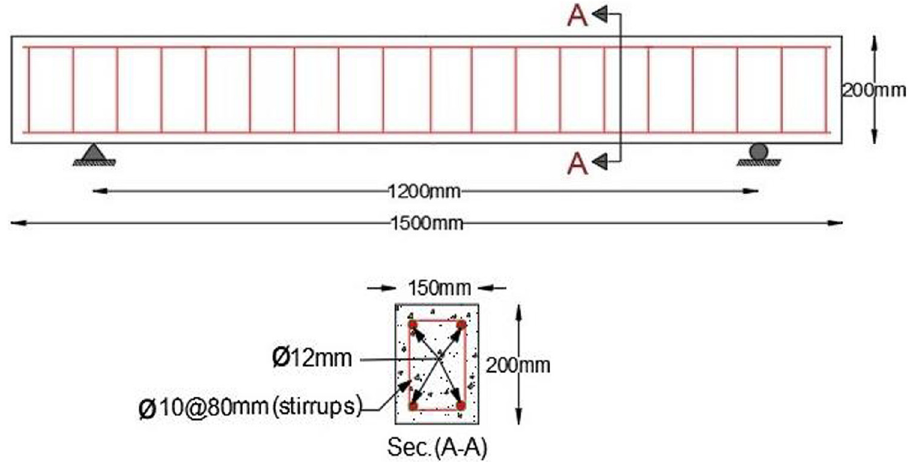
Figure 1: Tested specimen dimensions and reinforcement